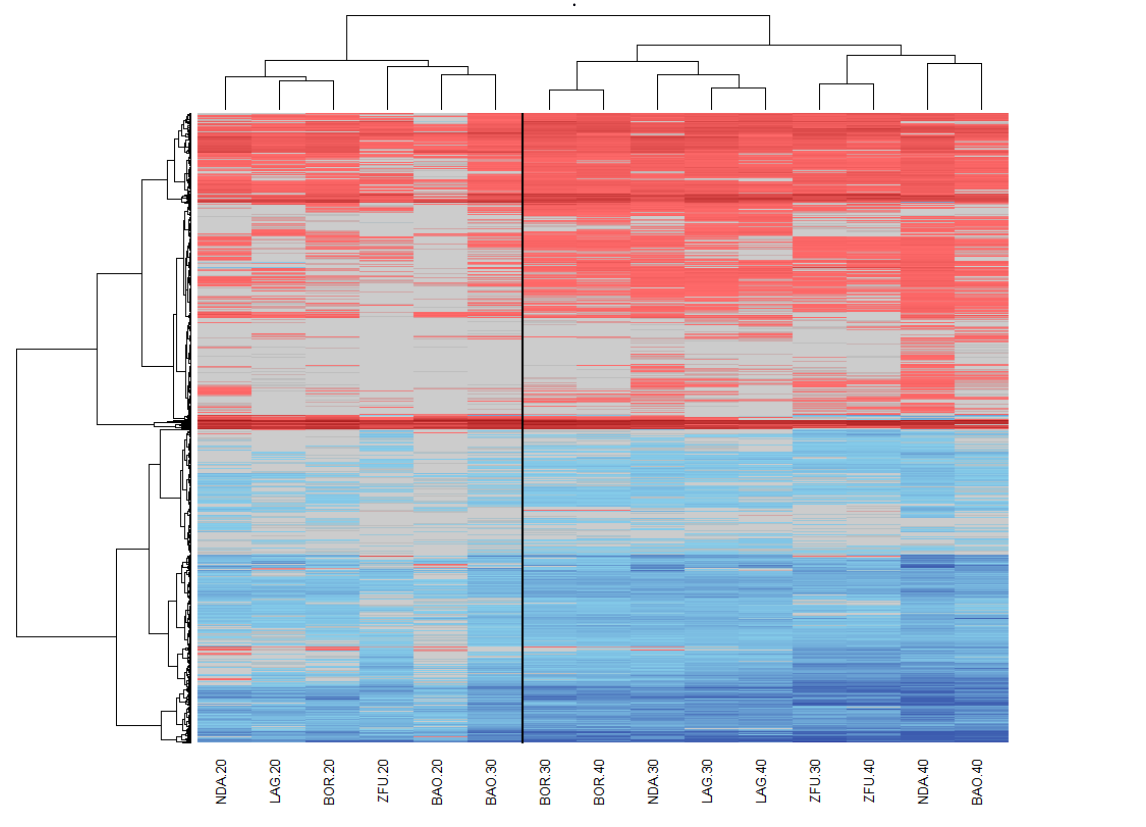
Figure 4 - Heatmap on the logFC of 5,270 DEGs in the 15 within-breed contrasts. Columns represent the within-breed contrasts ordered according to clustering, and rows the genes identified as DE in at least one contrast. Up-regulated genes (i.e. with positive logFC) are colored in warm colors from light red to dark red (estimated maximum logFC=11.3), whereas down-regulated genes (i.e. with negative logFC) are colored in cold colors, from light blue to dark blue (estimated minimum logFC=-8.00). LogFC comprised between -0.20 and 0.20 are colored in